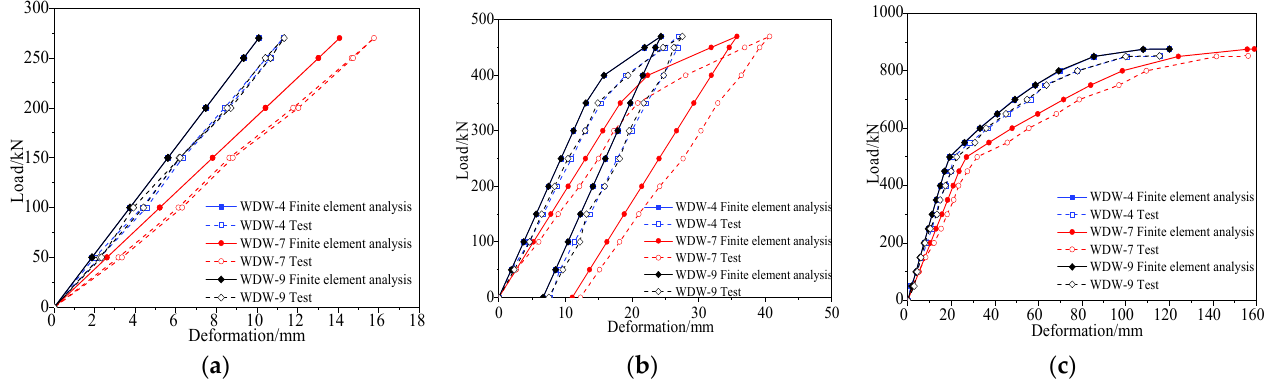
Figure 10. Deformation vs. load of the undamaged box girder. ( a ) First cycle of loading and unloading; ( b ) Second cycle of loading and unloading; ( c ) Third loading to failure.